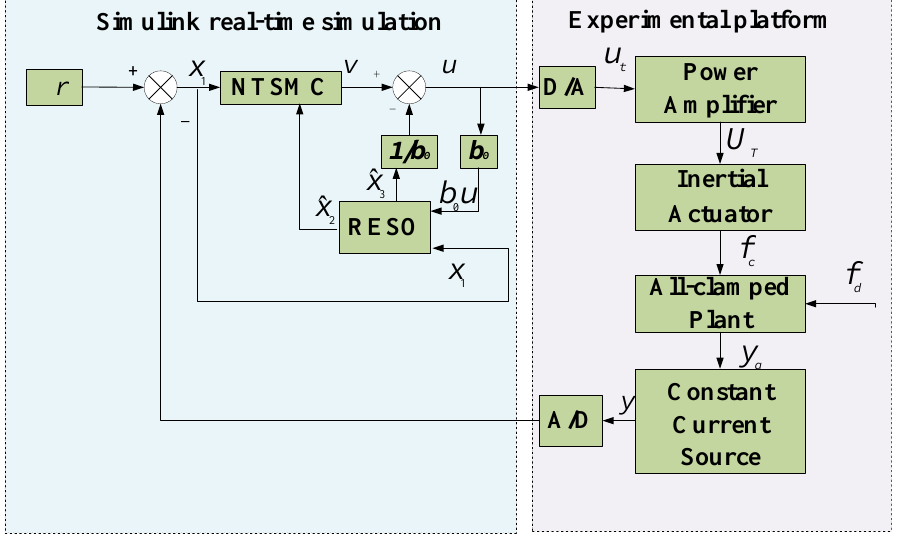
Figure 3. System diagram of the structural vibration suppression with RESO-NTSMVC.